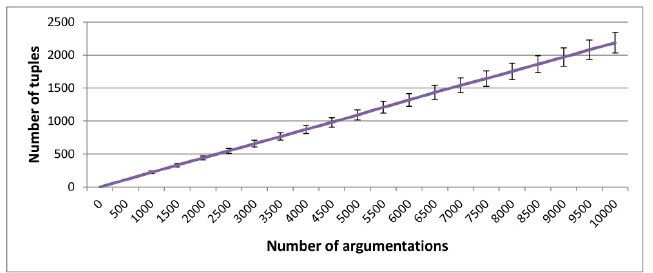
Figure 6. Average of tuples to improve a negotiation protocol model with argumentation executions across the total number of argumentations (100 experiments). Error bars show the standard